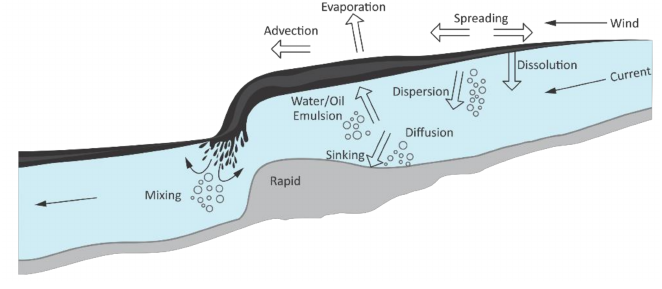
Figure 1. Oil spills in